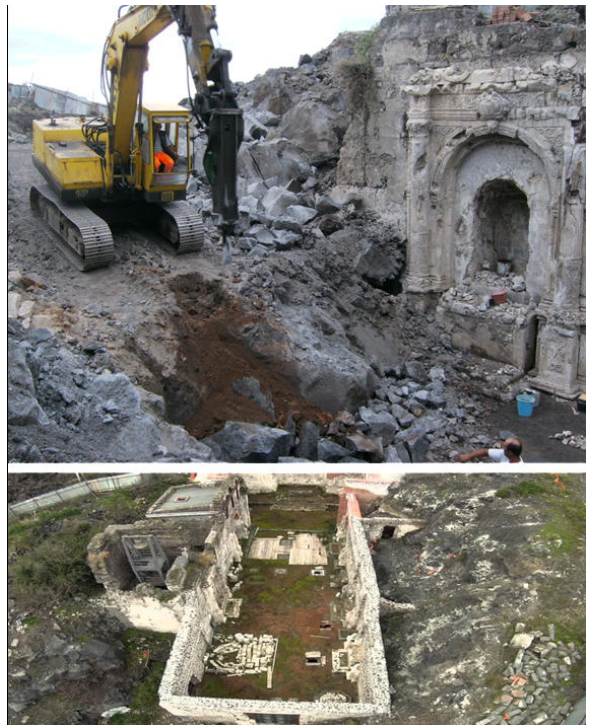
Figure 2. The excavations works at the church of Santa Maria delle Grazie in ancient Misterbianco.